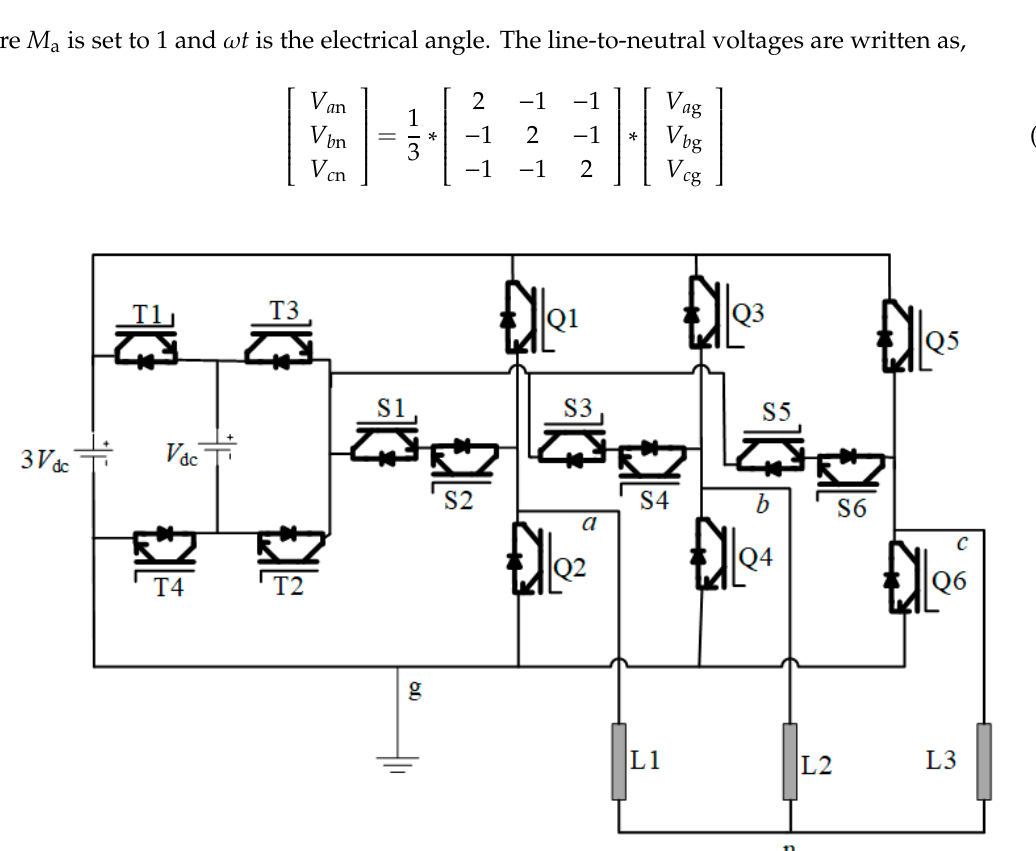
Figure 1. Schematic of the proposed four-level T-type converter (4LT 2 C) where each single-bridge leg of the T-type VSC resembles the shape of the rotated character “T”.